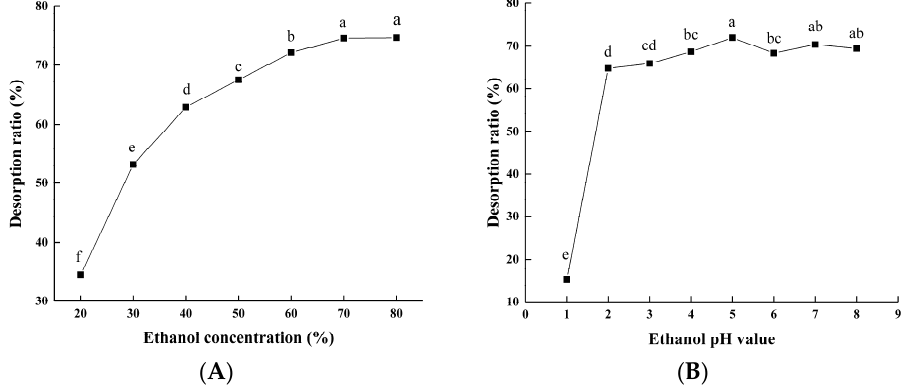
Figure 2. Effects of ethanol concentration ( A ) and pH value ( B ) on desorption rate of macroporous resin. Experiments were performed in triplicate, and data are expressed as the mean ± SE. Different lowercase superscript letters denote statistically significant differences ( p < 0.05).